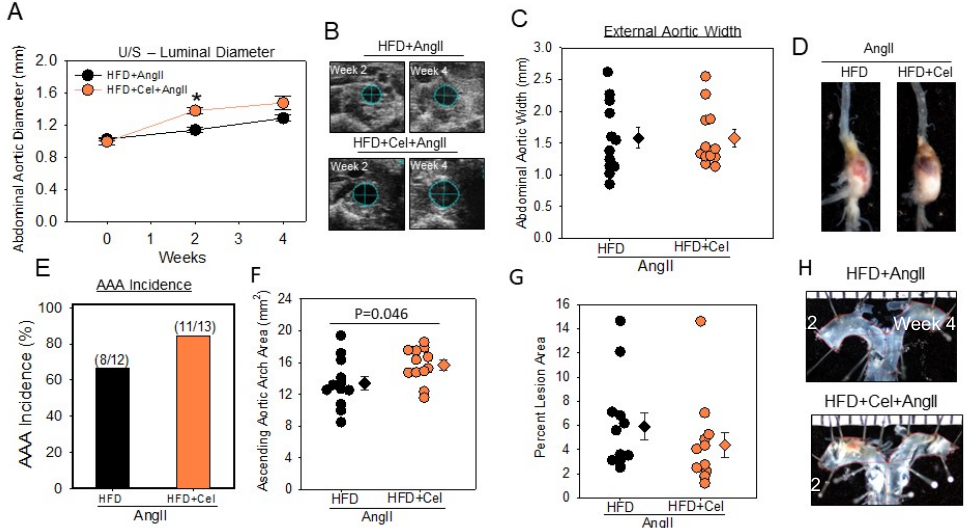
Figure 1. ( A ) Abdominal aortic luminal diameters were measured by ultrasound on weeks 0, 2, and 4 of AngII (1000 ng/kg/min) infusion in male mice (AngII + HFD n = 12; AngII + HFD + Cel n = 13). ( B ) Ultrasound pictographs of suprarenal aortas of individual mice at weeks 2 and 4 nearest to the mean of the group. ( C ) Measurements of maximal external width of abdominal aortas (AngII + HFD n = 12; AngII + HFD + Cel n = 13). Black (AngII + HFD) and orange (AngII + HFD + Cel) circles represent individual mice, diamonds represent means, and bars are SEMs. * Denotes p < 0.001 when comparing AngII + HFD vs. AngII + HFD + Cel (Student’s t test). ( D ) Representative images of abdominal aortas nearest the mean of each group. ( E ) The incidence of AAA in AngII-infused HFD (black bar) or HFD + Cel (orange bar) supplemented groups of mice. Statistical analyses were performed by Fisher’s exact test. ( F ) Area of ascending aortic arch and atherosclerotic lesion area ( G ) was measured on the intimal surface of the aortic arch. p = 0.046 when comparing AngII + HFD vs. AngII + HFD + Cel (Student’s t test). ( H ) Representative images of ascending aortas nearest the mean of each group. AngII: angiotensin II, HFD: high-fat diet, Cel: